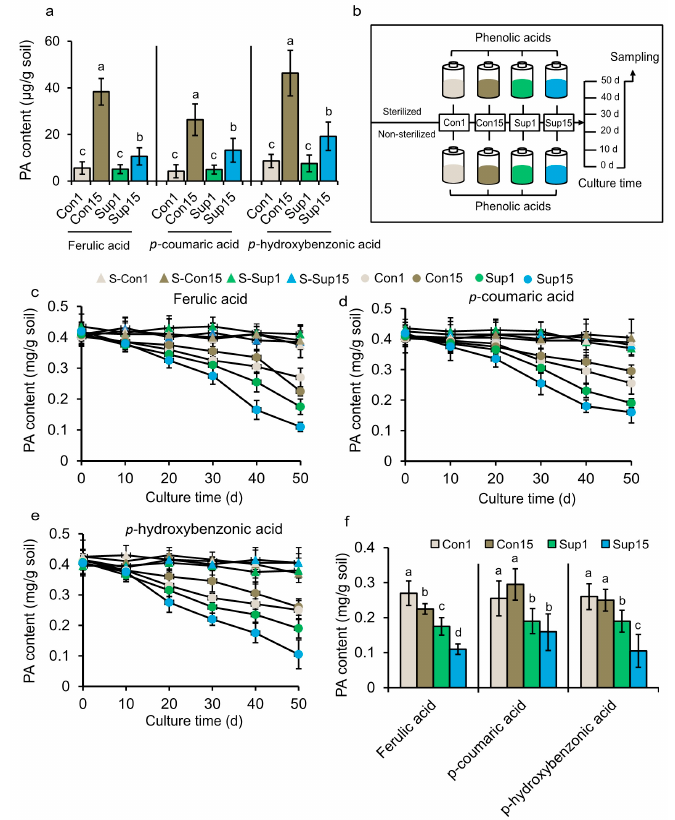
Figure 6. Analyses of the content of phenolic acids (PAs) and its degradation in both the conducive and suppressive soils. ( a ) The content of PAs in the soils. ( b ) Experimental scheme for evaluating the capacity of soils to degrade PAs. Different soil samples were amended with 0.5 mg/g PAs. During 50 d of culture, soil samples were harvested at different time points and used to measure the remaining PAs, including ferulic ( c ), p -coumaric ( d ) and p -hydroxybenzonic acids ( e ). At 50 d of culture, a fraction of the remaining PAs was calculated in both the conducive and suppressive soils ( f ). S-Con1, -Con15, -Sup1 and –Sup15: sterile soil samples. Con1, Con15, Sup1 and Sup15: non-sterile soil samples. Data are means ± SE. Different letters above the bars indicate statistically significant differences at p < 0.05 by Tukey's HSD test.